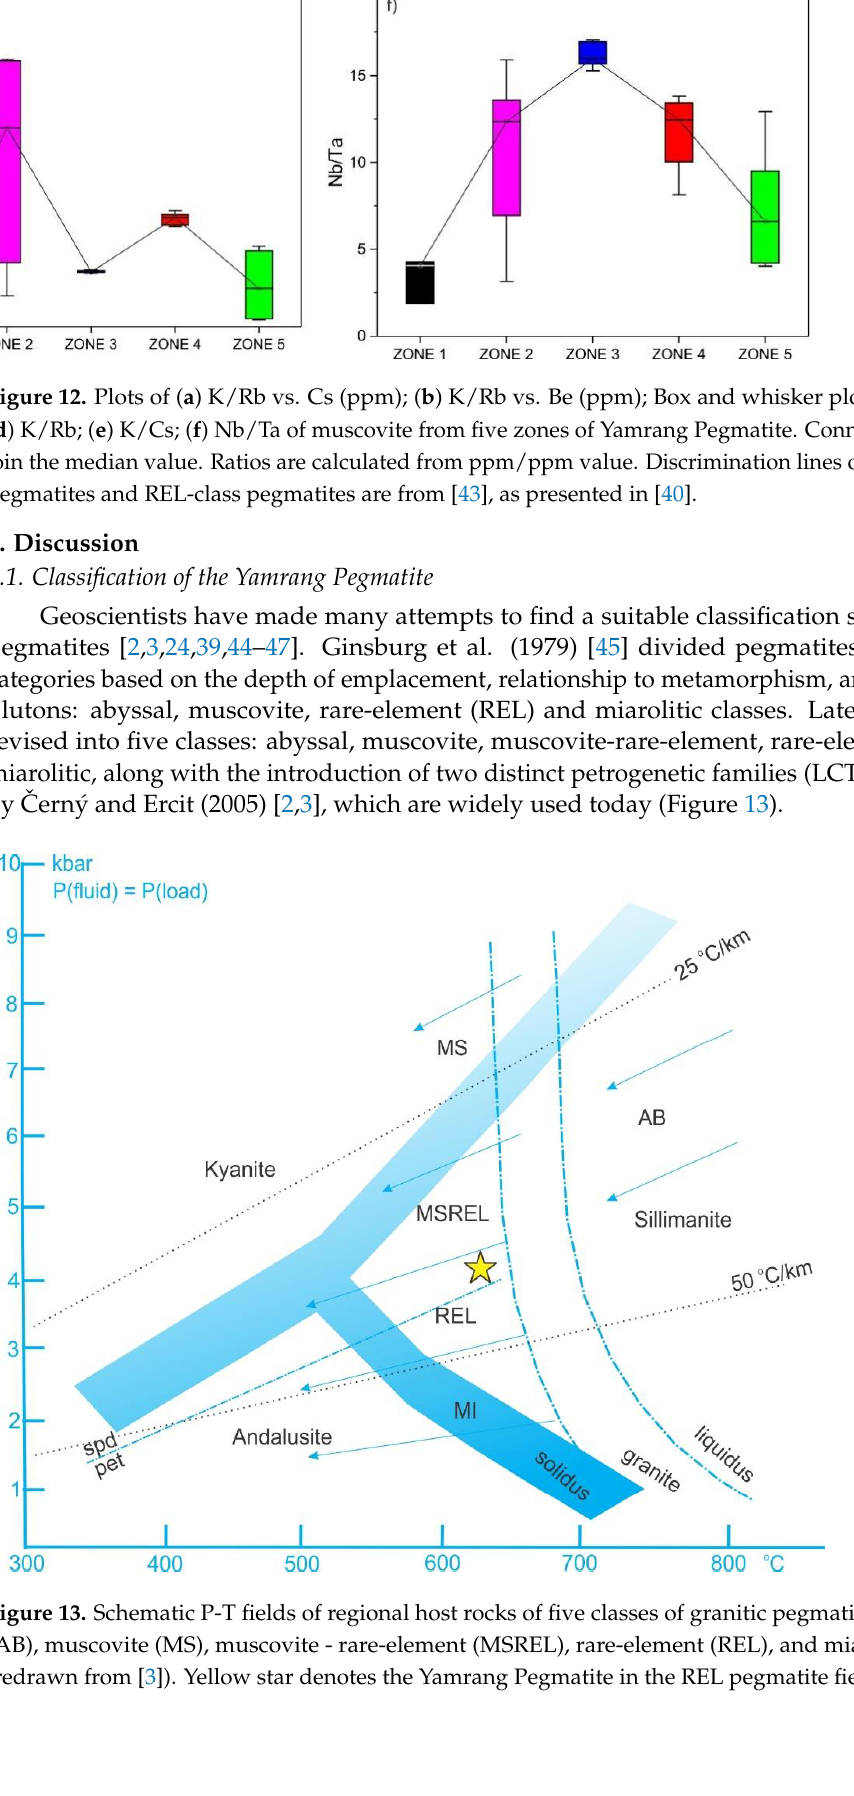
(redrawn from [3]). Yellow star denotes the Yamrang Pegmatite in the REL pegmatite